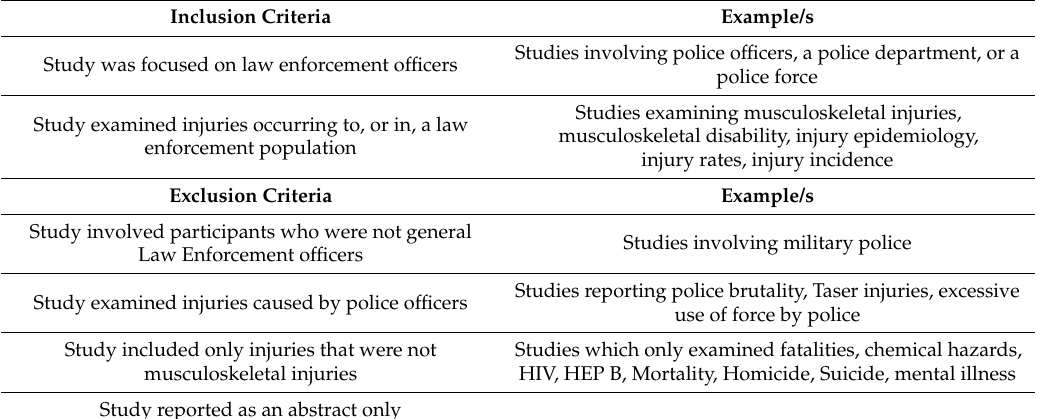
Table 2. Inclusion and exclusion criteria and examples of excluded